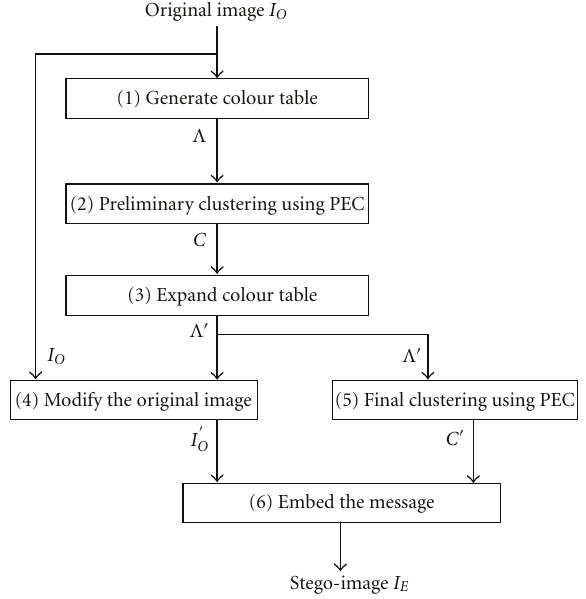
Figure 1: The framework of the PEC-based steganographic scheme.